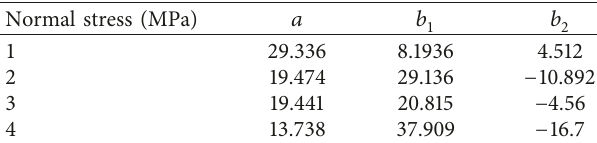
Table 3: Fitting parameters for peak dilation angle with different normal